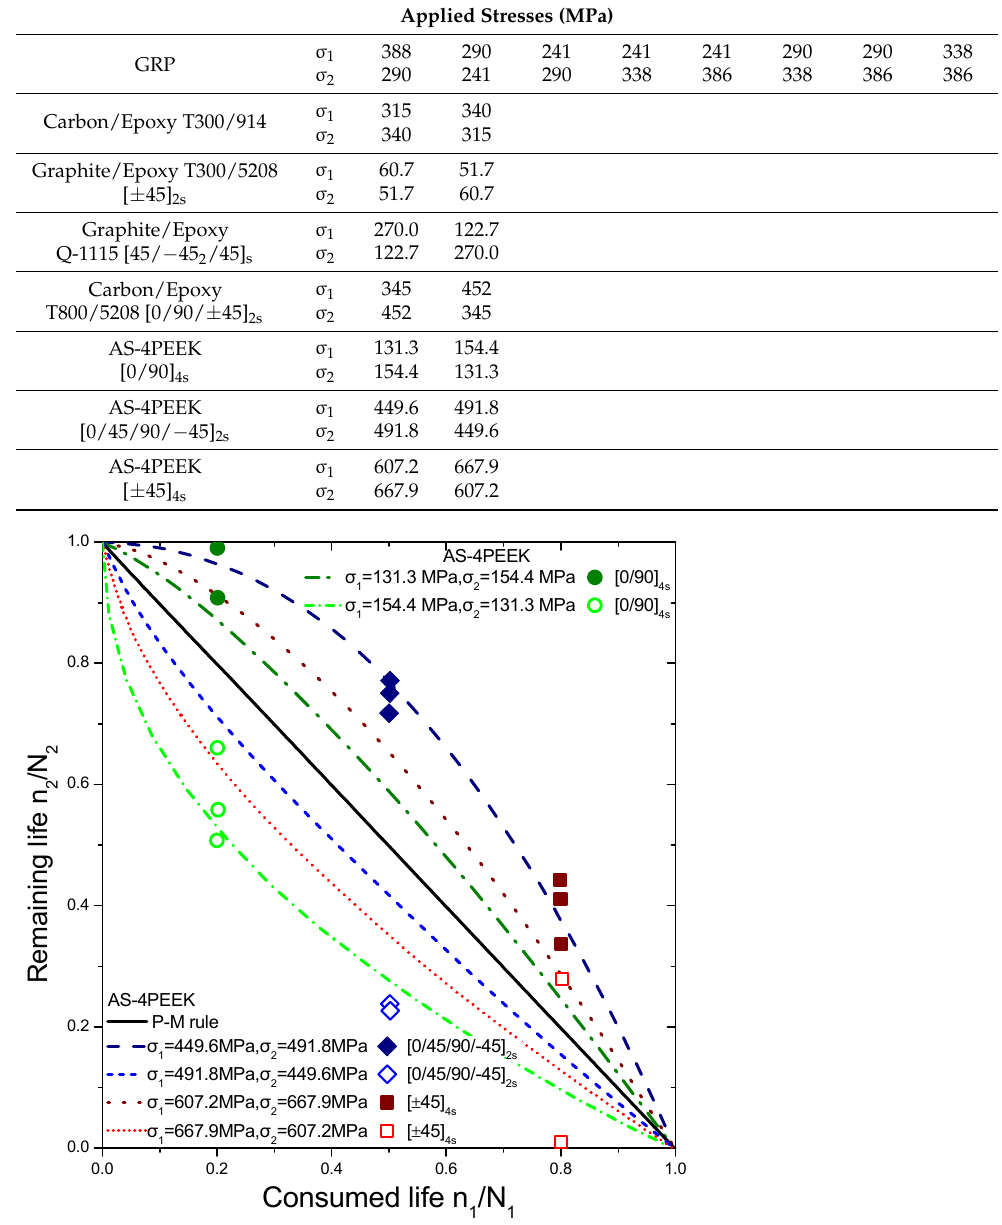
Figure 8. Remaining life versus consumed life analytical predictions for the case of AS-4/PEEK com- posite laminates. The experimental data points are taken from Ref